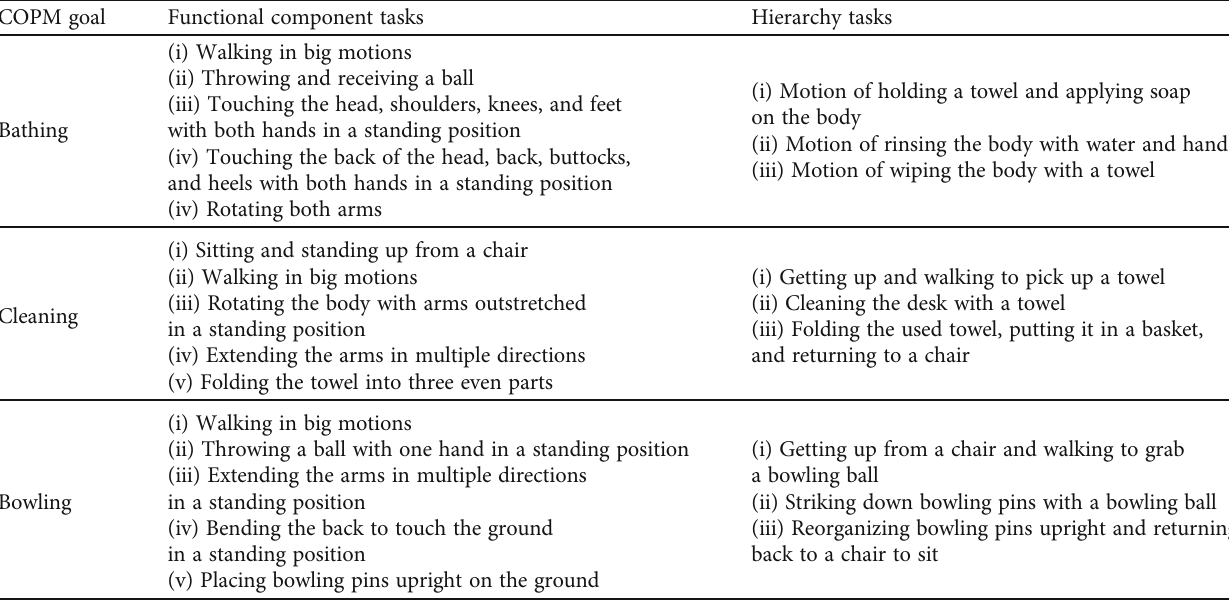
Table 2: Functional component tasks and hierarchy tasks re fl ecting the needs of participants (example of participant A). COPM